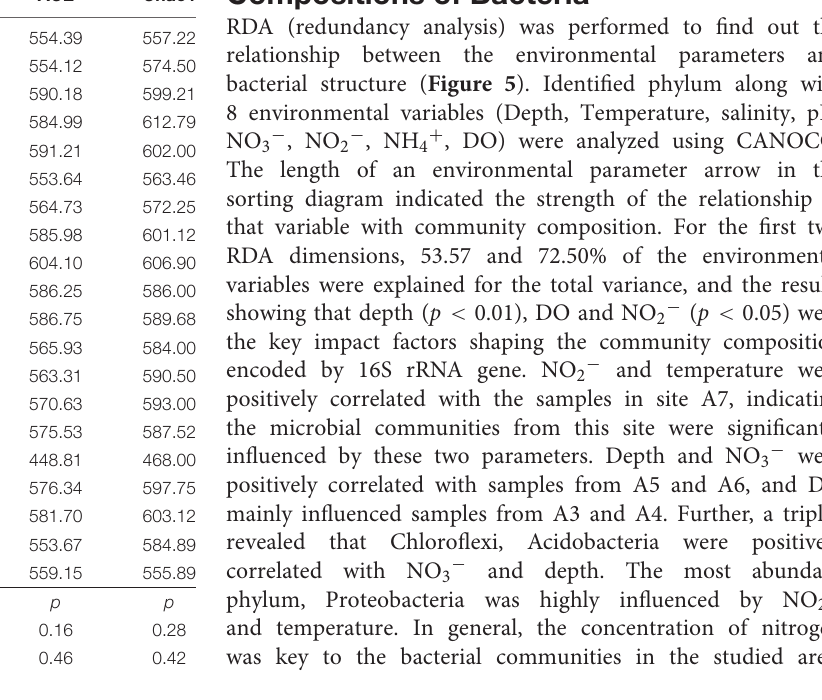
A4 ( p < 0.05) ( Supplementary Table 2 ), which were only slightly recovered in August. The KOs responsible for nitrogen fixation were found to be abundant in offshore sites and